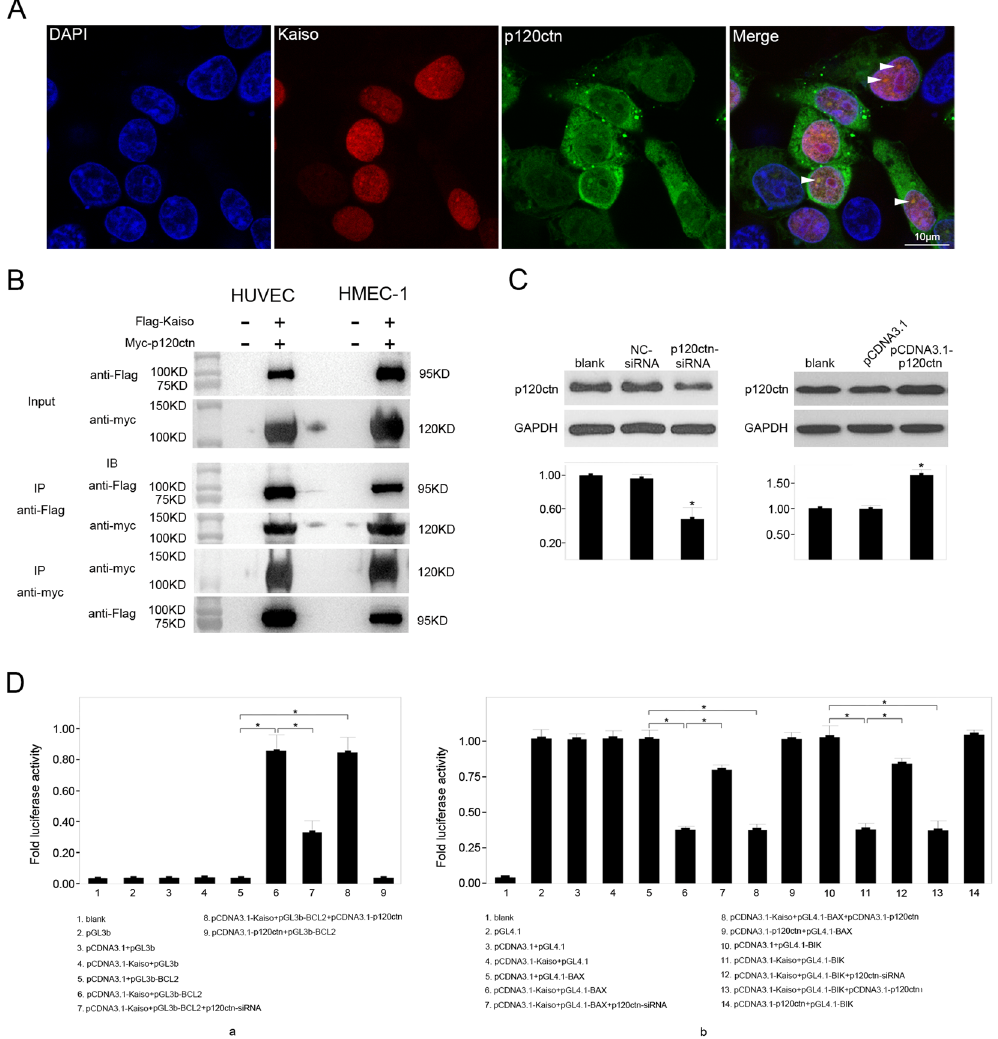
Figure 9. P120ctn participates in the gene regulation of BCL2, BAX and BIK by Kaiso. HUVECs were transfected with pCDNA3.1-Kaiso for 48 h and stained with polyclonal rabbit anti-Kaiso (H-154) antibody (in red color) and monoclonal mouse anti-p120ctn antibody (in green color) ( A ). Cell nuclei were stained with DAPI ( A ,a). Arrowheads show the particle like structures where both Kaiso and p120ctn were observed ( A ,d). Scale bar represents 10 μ m. HUVECs and HMEC-1s were co-transfected with pCMV-flag-Kaiso and pCMV- myc-p120ctn, and 48 h later the interaction of Kaiso and p120ctn was evaluated by co-immunoprecipitation using monoclonal mouse anti-FLAG antibody and monoclonal mouse anti-Myc tag antibody respectively ( B ). HUVECs were transfected with NC-siRNA, p120ctn-siRNA, pCDNA3.1 and pCDNA3.1-p120ctn respectively, and p120ctn expression was evaluated by Western blot 48 h after transfection ( C ). GAPDH served as a loading control. Values are presented as mean ± SD, * p < 0.01, compared with blank, n = 3. HUVECs were transfected with recombinant firefly luciferase reporter constructs pGL3b-BCL2 ( D ,a), pGL4.1-BAX and pGL4.1-BIK ( D ,b), together with pCDNA3.1, pCDNA3.1-Kaiso, pCDNA3.1-Kaiso and p120ctn-siRNA, pCDNA3.1-Kaiso and pCDNA3.1-p120ctn, and pCDNA3.1-p120ctn, respectively. Renilla luciferase reporter pRL-TK was used as an internal control. The untreated HUVECs served as a blank. Relative luciferase activity is presented as mean ± SD. * p < 0.01, n =